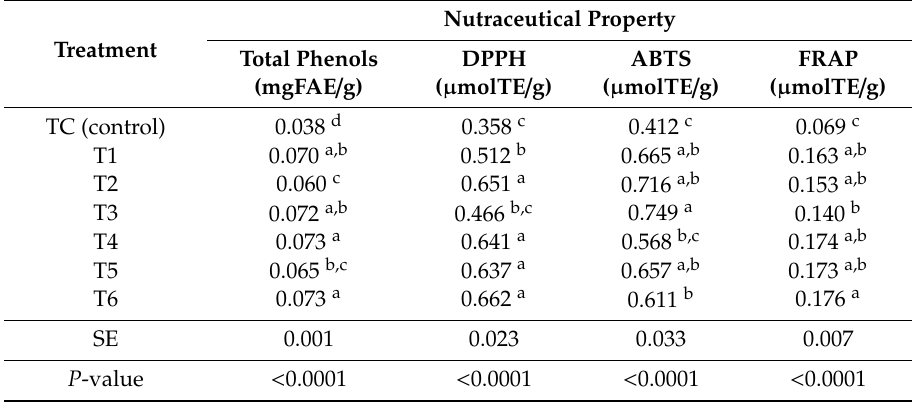
Table 4. Total phenolics and antioxidant capacity of frankfurter sausages treatments. Nutraceutical Property Treatment